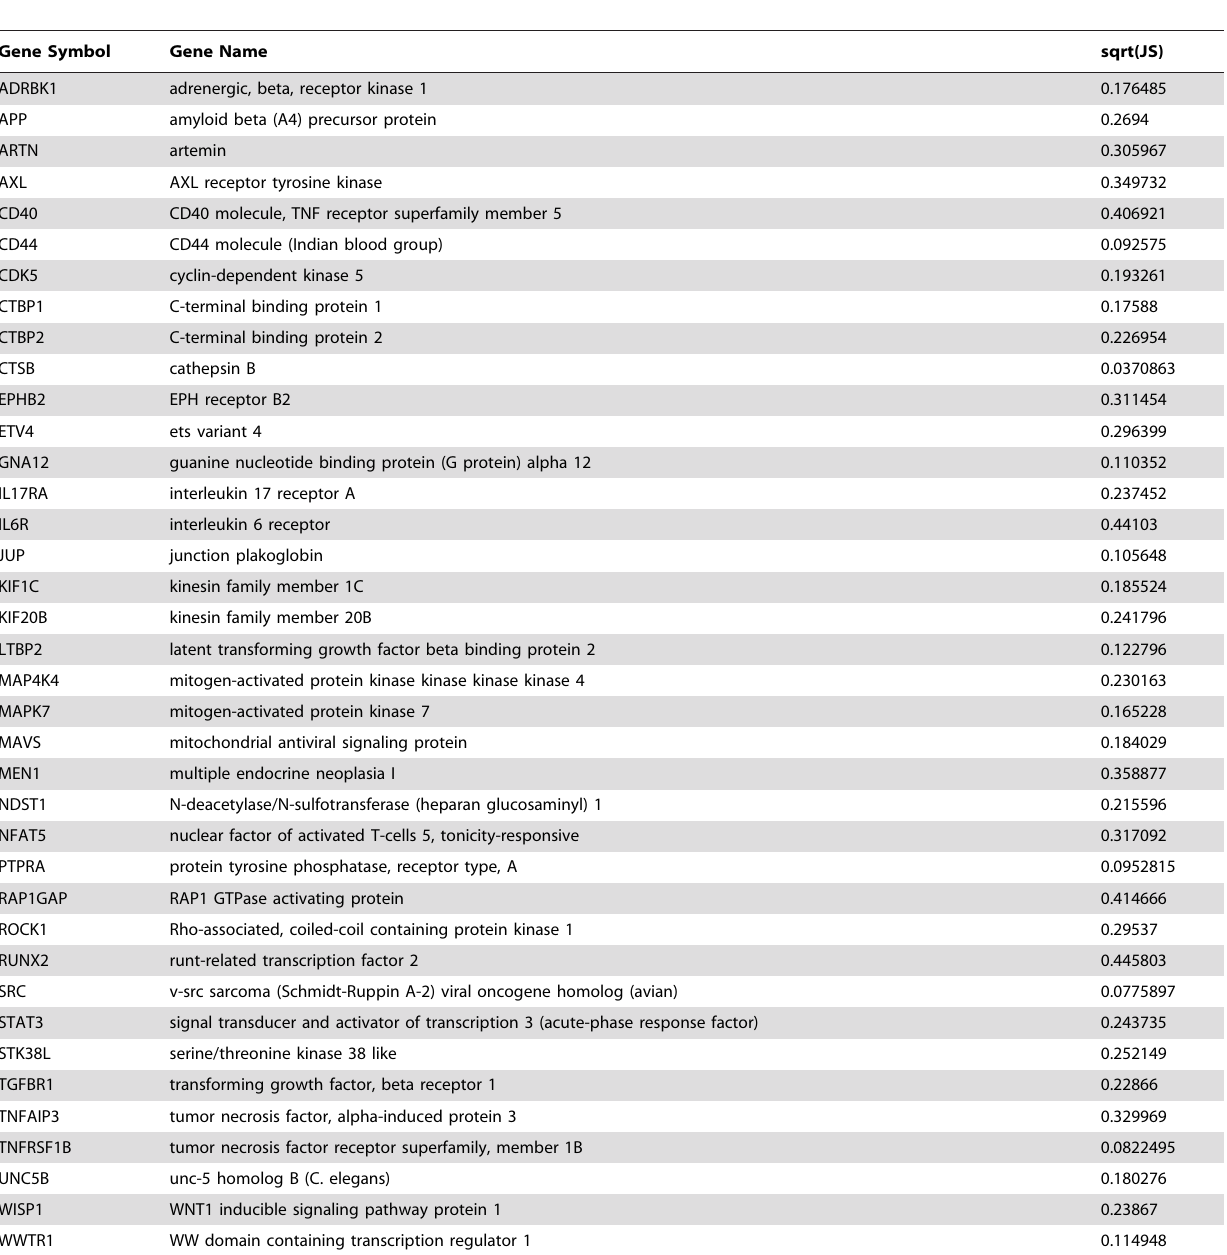
Table 4. Differential exon usage for cell movement associated genes in Wnt5a compared to vector control cells.